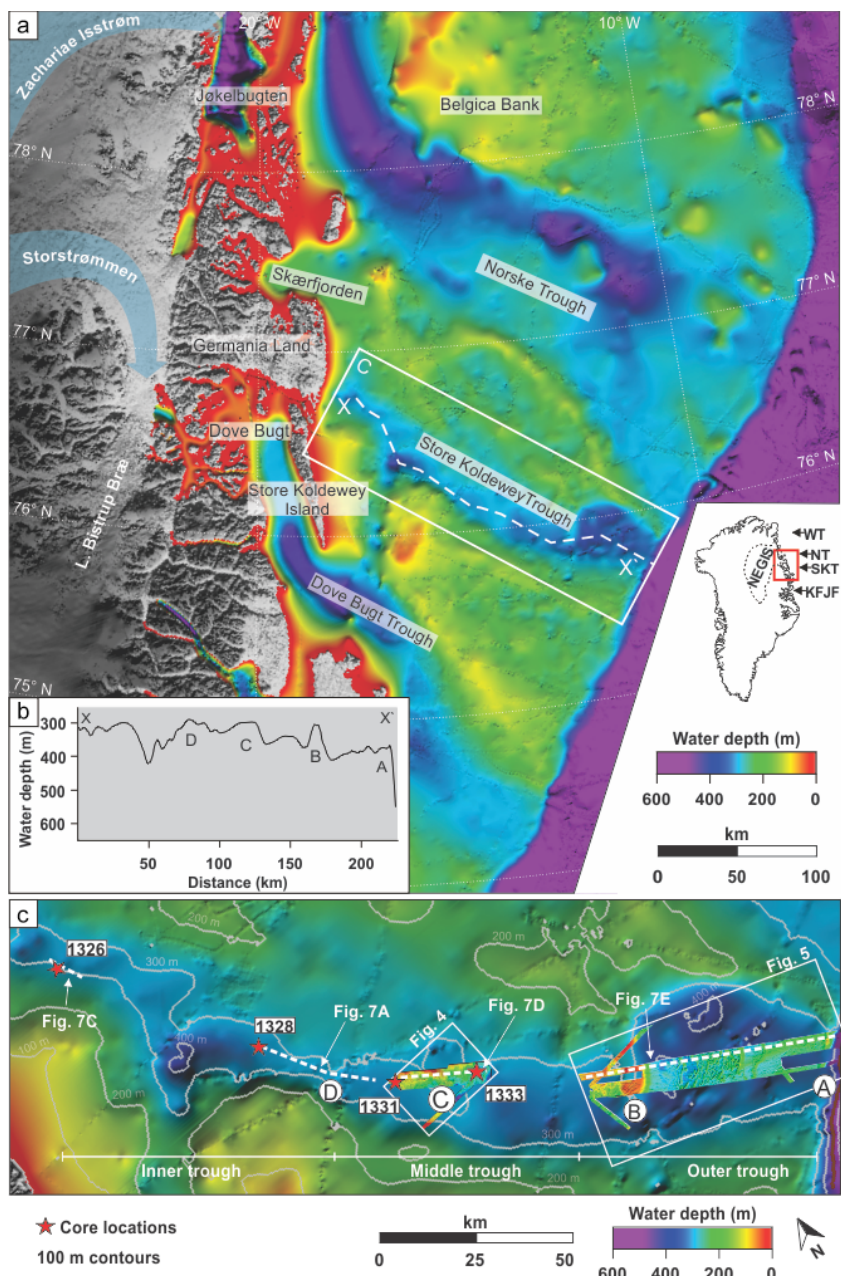
Figure 1. (a) Overview of the regional bathymetry and the hinterland topography of NE Greenland (from IBCAO v.4.0; Jakobsson et al., 2020) including geographical names. The small map shows Greenland and the outline of the NEGIS, with the red box showing the study area detailed in panel (a) . The locations of Westwind Trough (WT), Norske Trough (NT), Store Koldewey Trough (SKT) and Kejser Franz Josef Fjord (KFJF) are indicated. The white dashed line shows the location of the bathymetric profile shown in panel (b) . (b) Bathymetric profile along the central axis of Store Koldewey Trough. The labels A–D show the locations of interpreted grounding zone wedges as described by Laberg et al. (2017). (c) Large-scale bathymetry of Store Koldewey Trough (from IBCAO v.4.0; Jakobsson et al., 2020) including the swath bathymetry data analyzed in this study. The labels A–D represent grounding zone wedges (adapted from Laberg et al., 2017); red stars show core